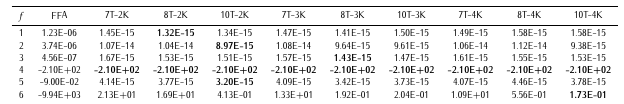
Table 5. Results: 20 fireflies and Crossover with Simulated Annealing with the K best threads